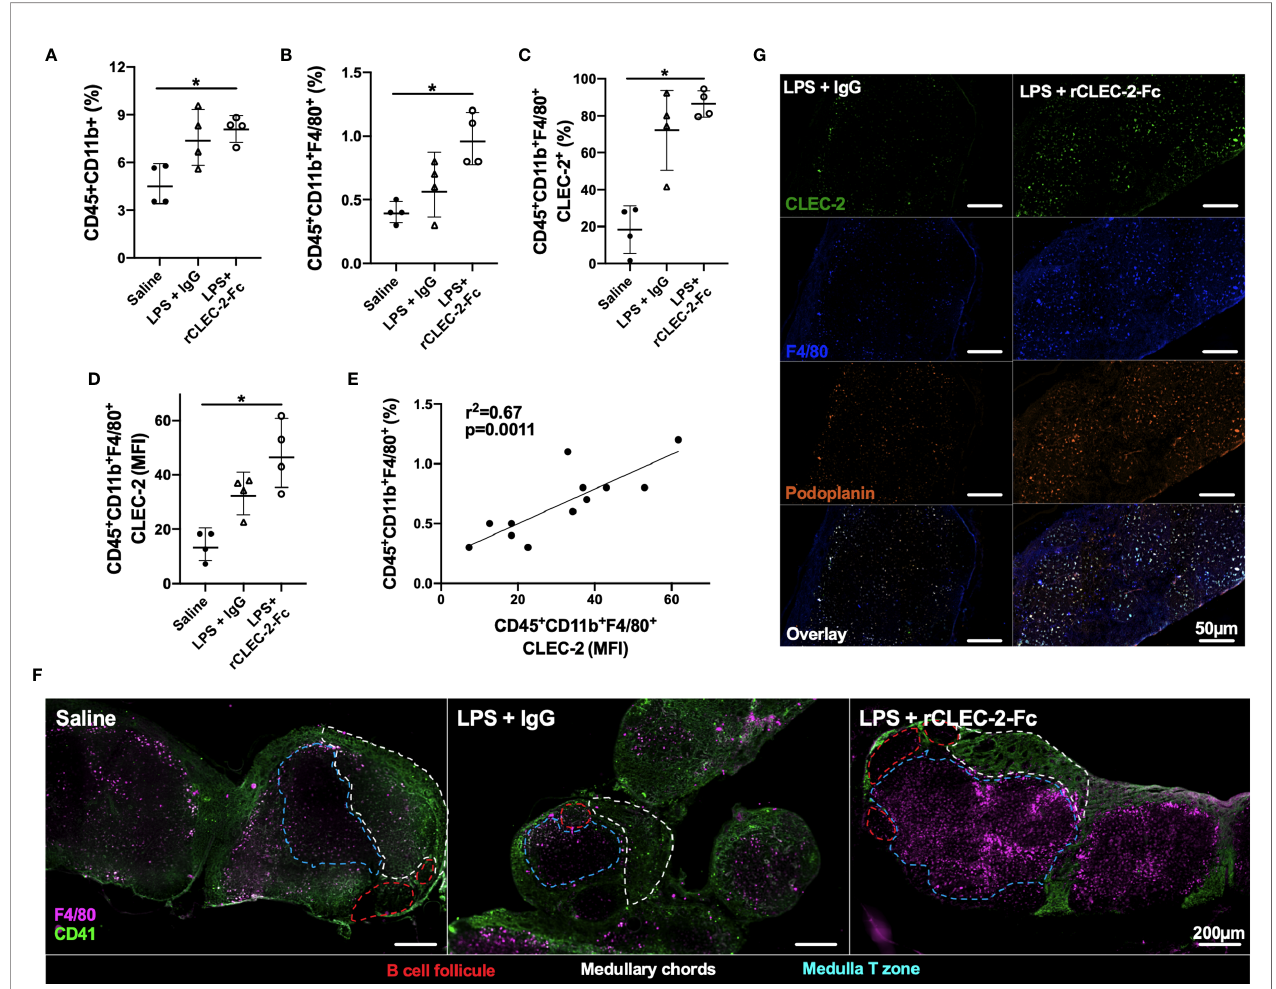
FIGURE 5 | rCLEC-2-Fc increases peritoneal macrophage migration to mesenteric lymph nodes during endotoxemia. WT mice were intraperitoneally injected with LPS (10mg/kg) for 18h followed by rCLEC-2-Fc or IgG isotype control (100µg/mouse) for an additional 4h (n=4). (A – E) Mesenteric lymph node (MLN) cells were collected and immune cell population detected by fl ow cytometry. (A) Percentage of myeloid cells (CD45 + CD11b + ) and (B) macrophages (CD45 + CD11b + F4/80 + ). (C) CLEC-2-positive macrophages and (D) the MFI of CLEC-2 expression on macrophages in MLN. (E) Correlation between the percentage of MLN macrophages and the MFI of CLEC-2 expression on macrophages by Simple Linear Regression. (F) Immuno fl uorescent staining of macrophages (F4/80; purple) and platelets (CD41; green) in frozen MLN sections. (G) Immuno fl uorescent staining of macrophages (F4/80; blue), CLEC-2 (green) and podoplanin (orange) in frozen MLN sections. The statistical signi fi cance was analyzed using a Kruskal-Wallis multiple comparisons test. * p